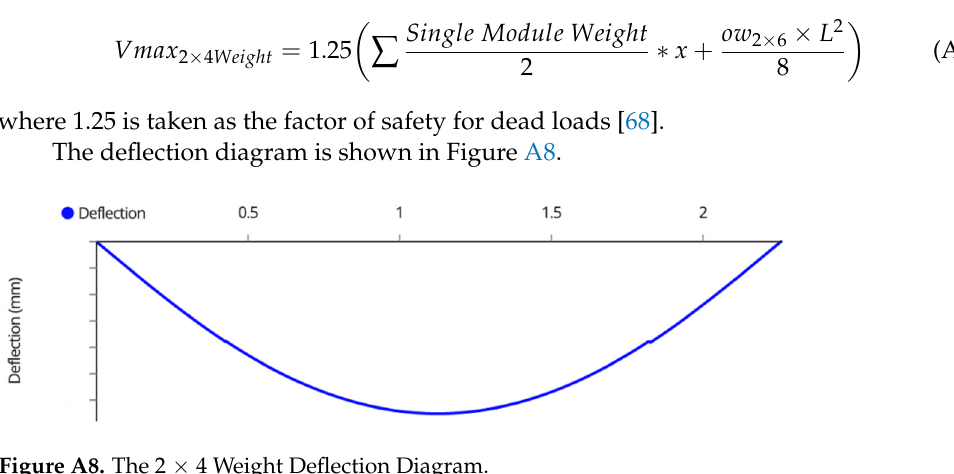
Figure A8. The 2 × 4 Weight Deflection Diagram.